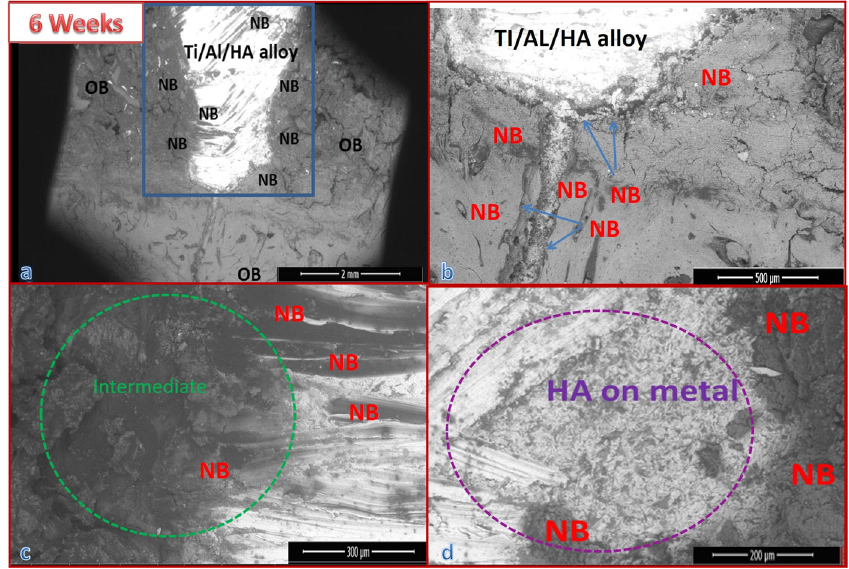
3.4.2.3 Histopathological fi ndings Figure 10a shows some focal areas for Group 1 (control). The fi gure indicates a loss in the histological Haversian system (H, black arrows), (at magni fi cation 100 µm). Figure 10b shows the histological picture of the femur bone for the dogs treated with bHA-